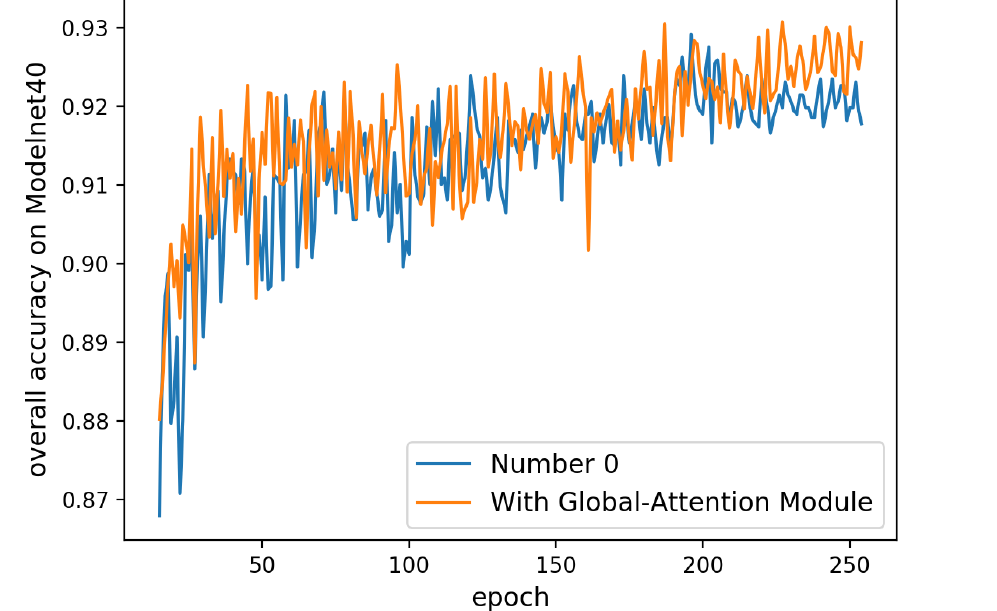
Figure 9. Overall accuracy of different models on ModelNet40 with epochs (epoch > 15). Number 0 means removing the Global-Attention Module and all SE-Blocks in our model. With Global-Attention Module denotes that we only remove SE-Blocks in our